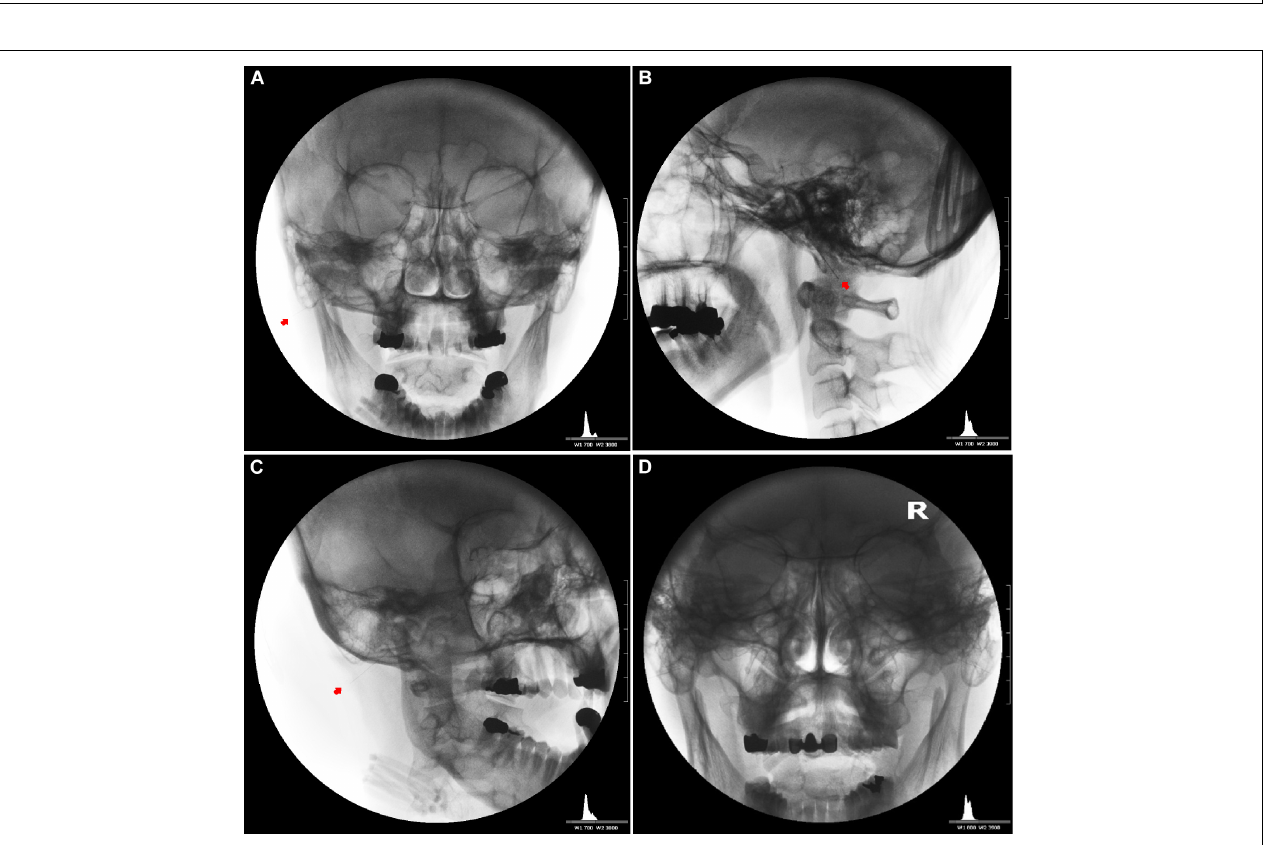
FIGURE 5 | Needle placement for the induction of bilateral facial nerve block after inducing vestibulocochlear (8th cranial nerve, CN VIII) stimulation indirectly via the facial nerve. Unilateral anteroposterior (A) , lateral (B) , oblique (C) , and bilateral anteroposterior (D) fluoroscopic views showing the tips of the needles close to the stylomastoid foramen between the mastoid process and the styloid